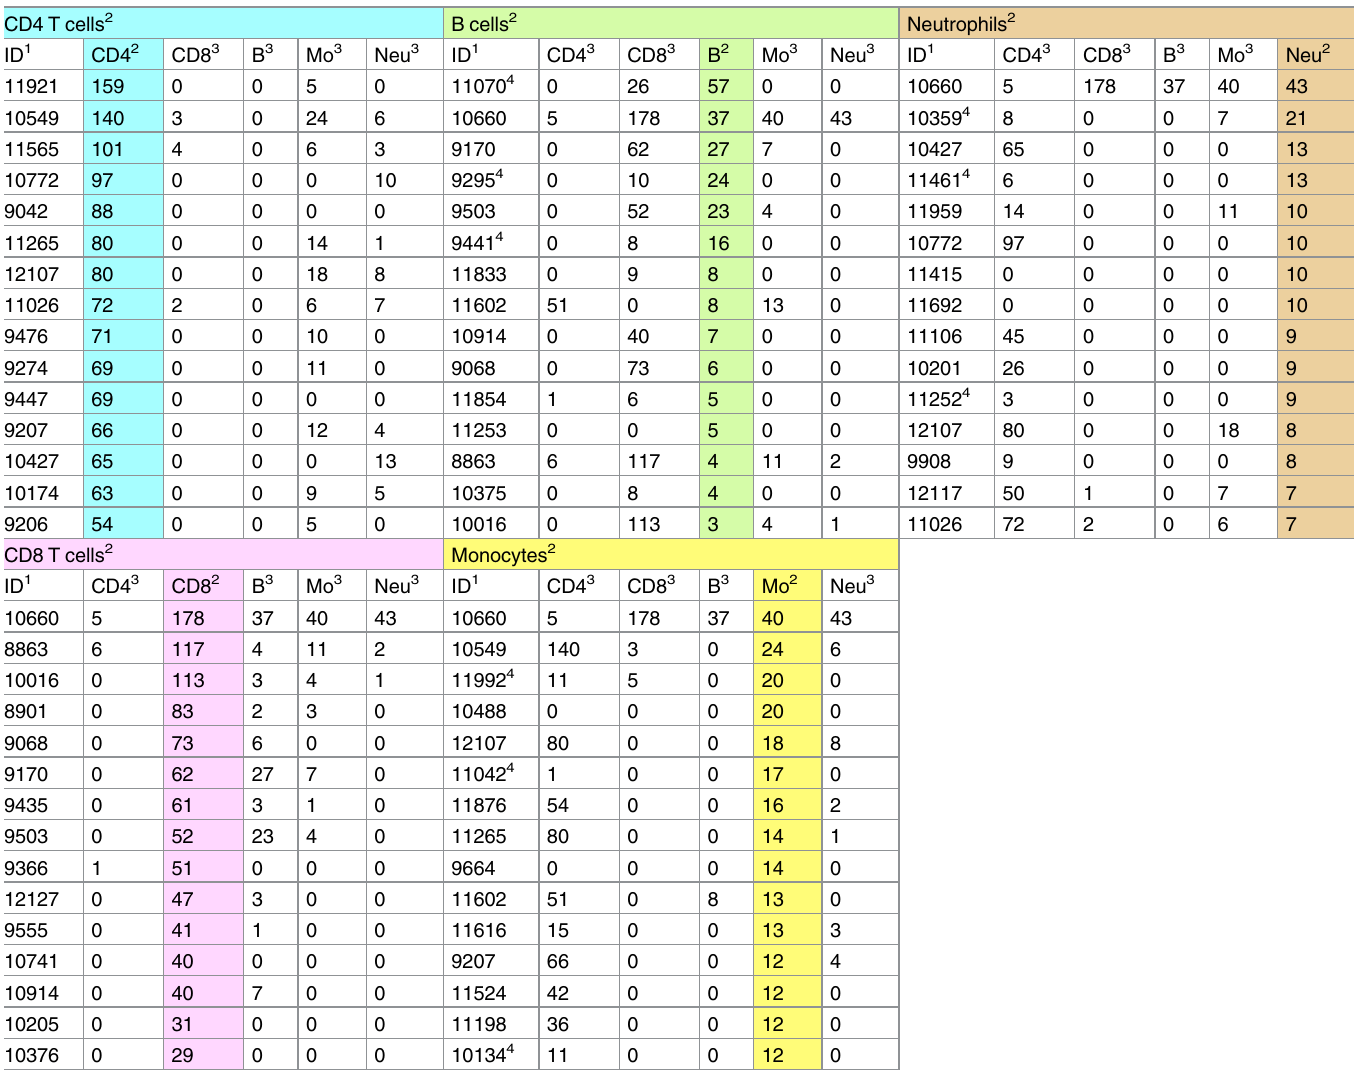
Table 3. Top 15 clones of each cell lineage in a HTLV-1